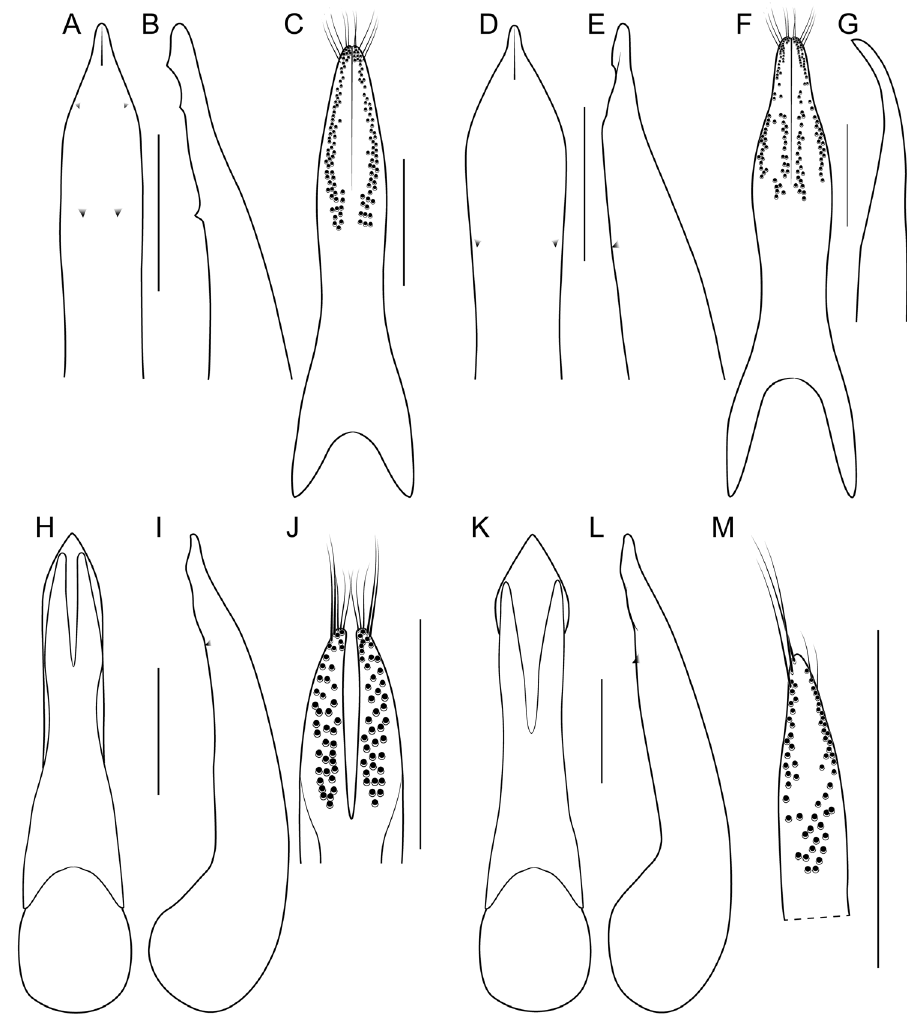
Figure 12. Bolitogyrus magnimaculosus Cai et al. ( A–C ), B. nokrek Brunke ( D–G ), B. lasti Rougem- ont ( H–J ) and B. tigris Brunke ( K–M ). Aedeagus in parameral view ( H, K ), median lobe in parameral view ( A, D ), median lobe in lateral view ( B, E, I, L ), peg setae of paramere ( C, F, J, M ), paramere in lateral view ( G ). Figures A–C modified from Cai et al. (2015). Scale bars: 0.5